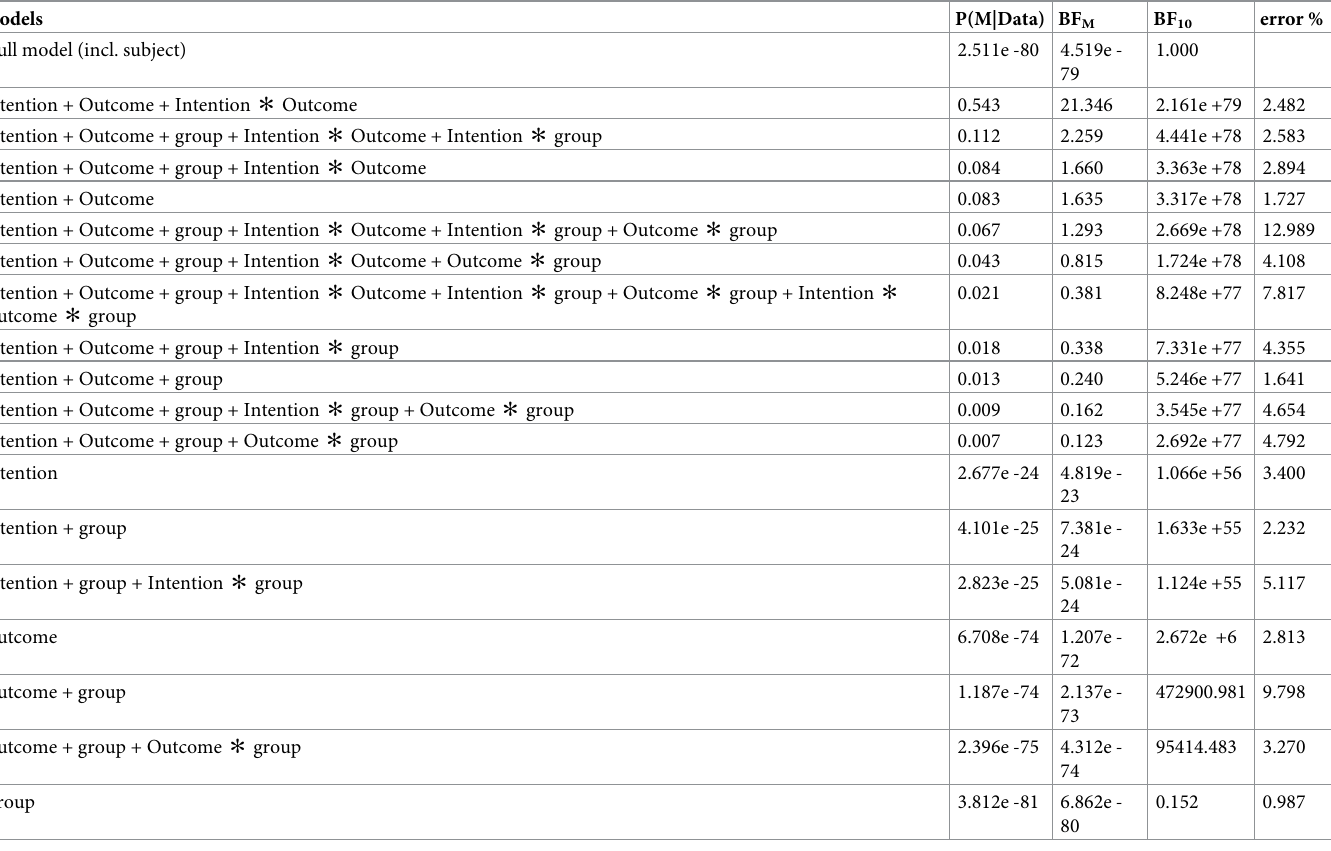
Table 3. Bayesian repeated measures ANOVA: Model comparison.